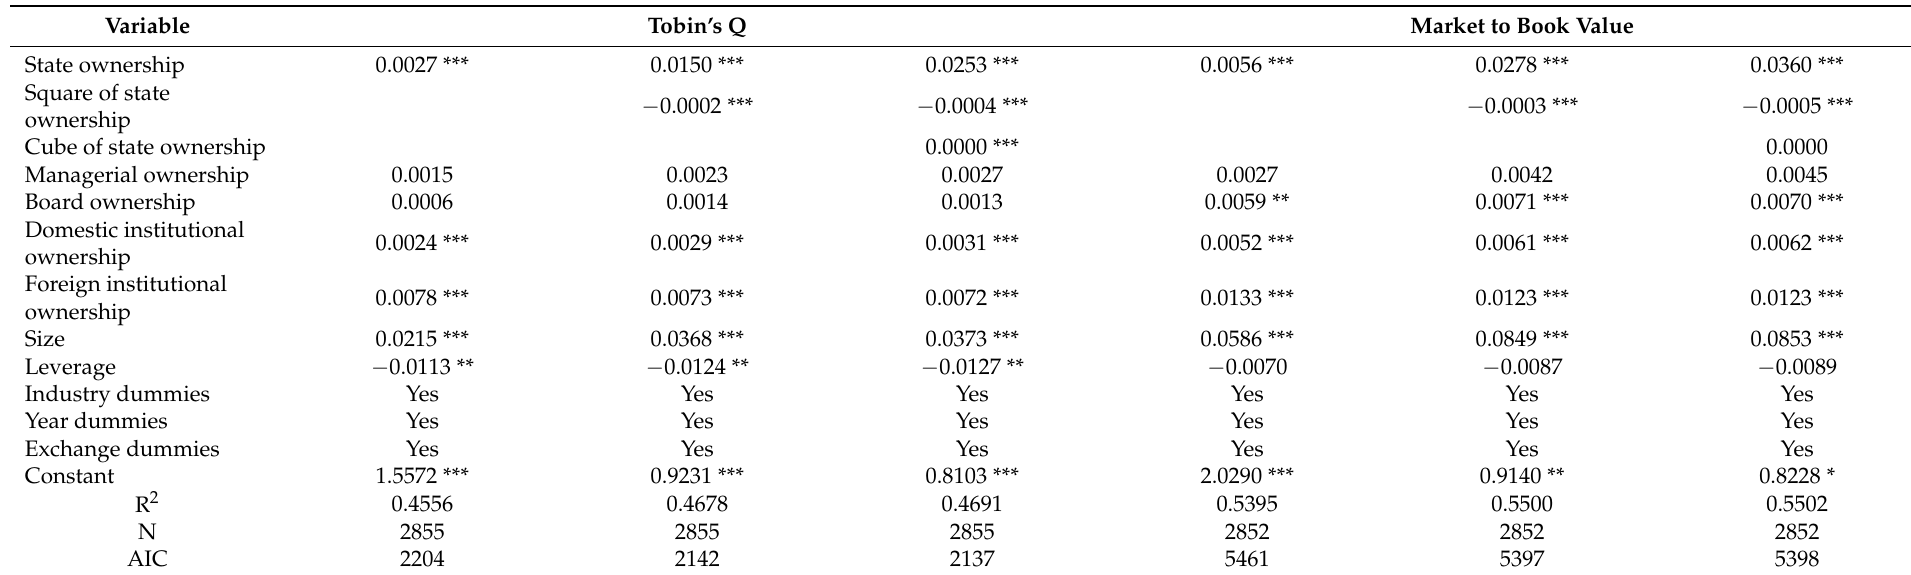
Table A3. Linear, quadratic, and cubic regressions of partially privatized firm market performance on residual state